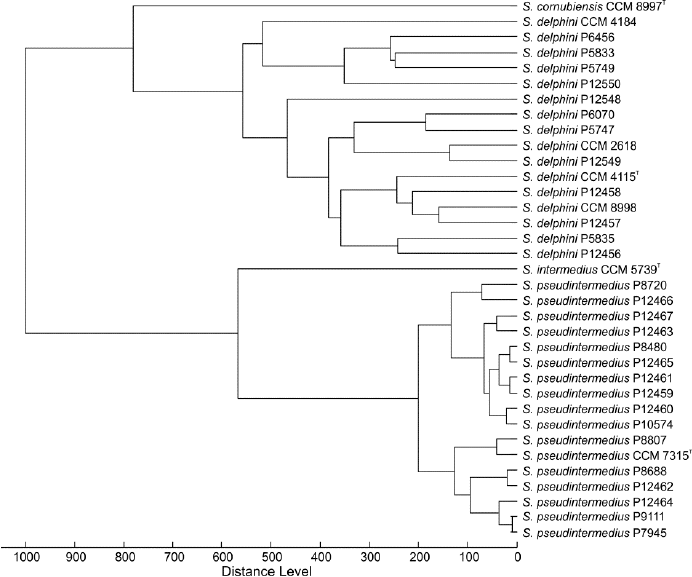
Figure 4. Matrix-assisted laser-desorption/ionization time-of-flight (MALDI-TOF) mass spectra-based dendrogram of analyzed isolates and type and reference strains of Staphylococcus intermedius group. The dendrogram was constructed using Pearson's product moment coefficient as a measure of similarity and the unweighted pair group average linked method (UPGMA) as a grouping method.